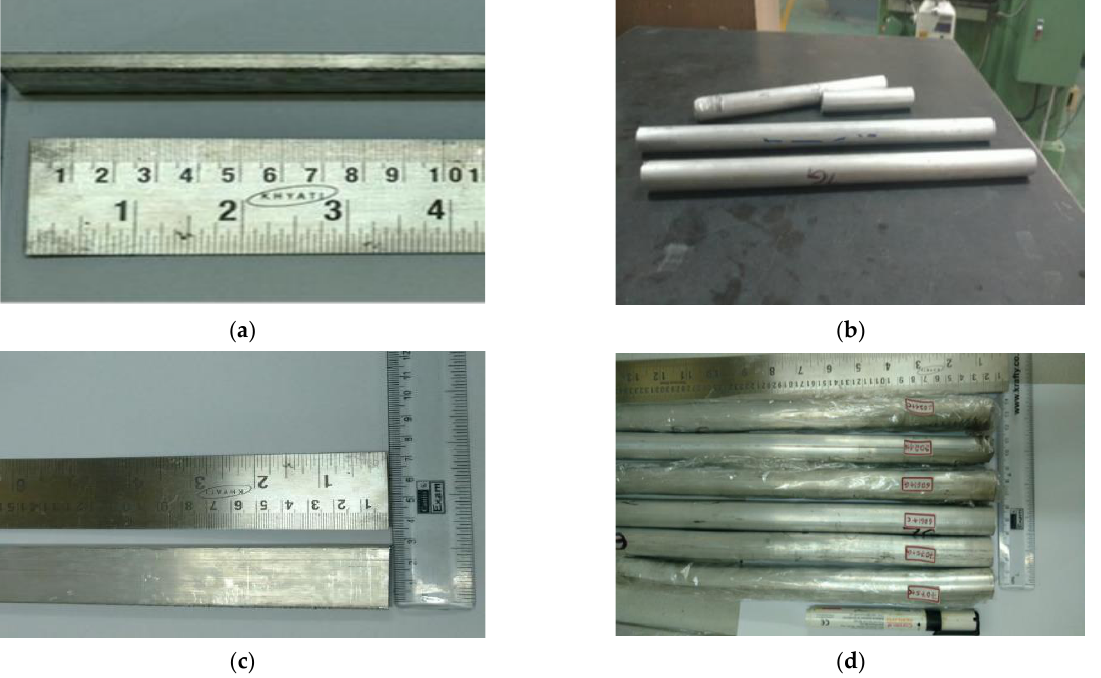
Figure 1. Extruded composites with 2 wt% graphene; ( a , c ) are the flat bar, and ( b , d ) are the round bar.